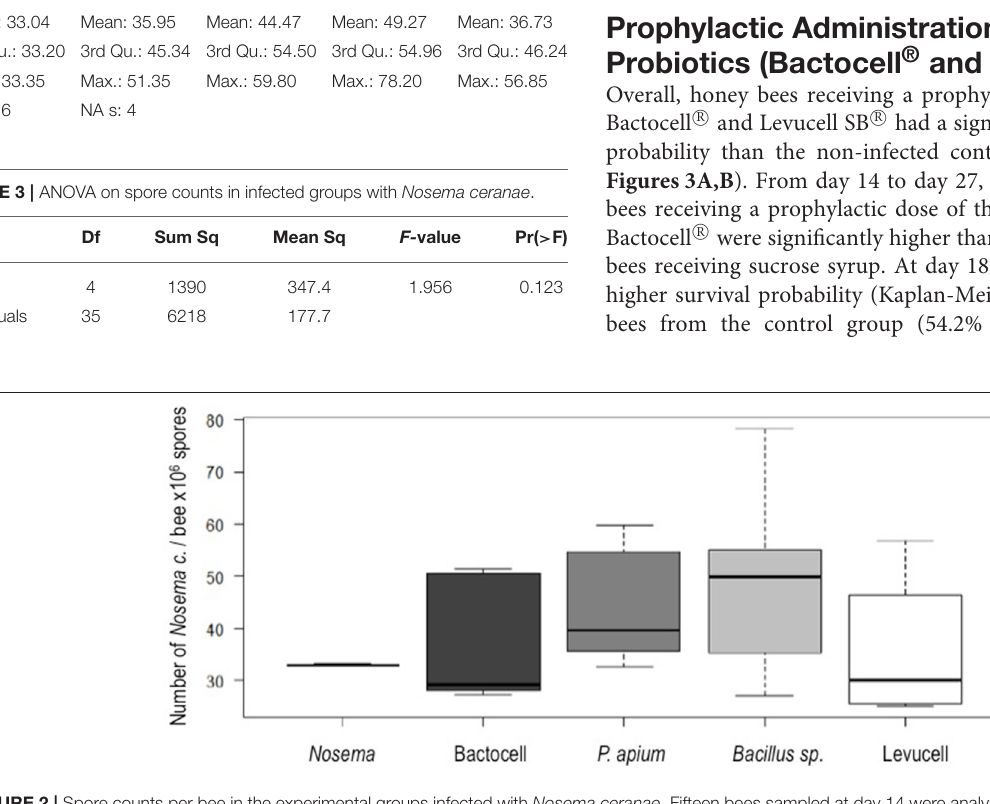
Frontiers in Ecology and Evolution |